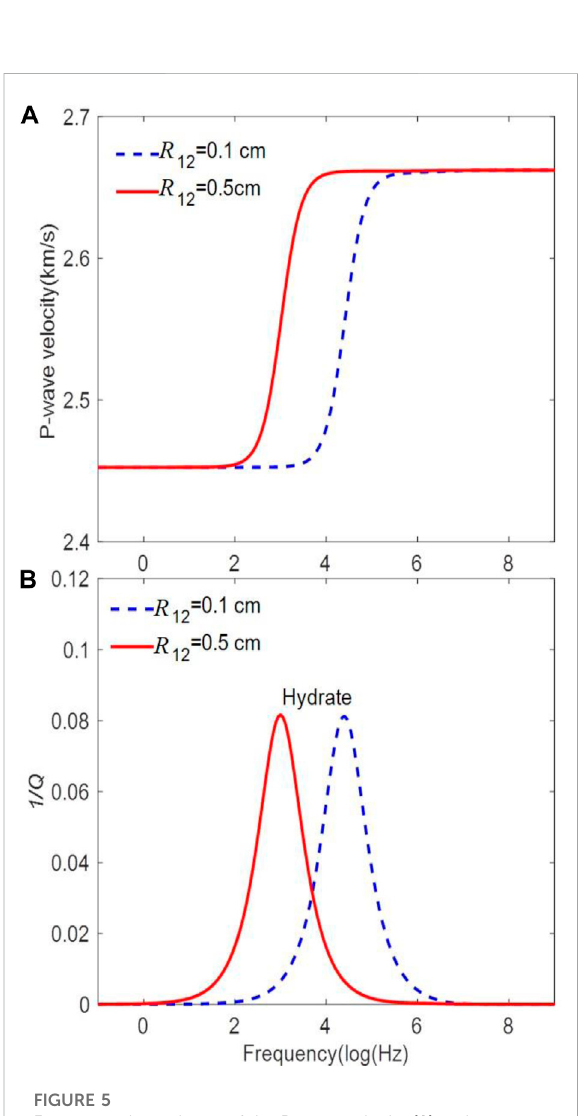
Frequency dependence of the P-wave velocity (A) and attenuation (B) corresponding to the triple-porosity model with two radii of the hydrate